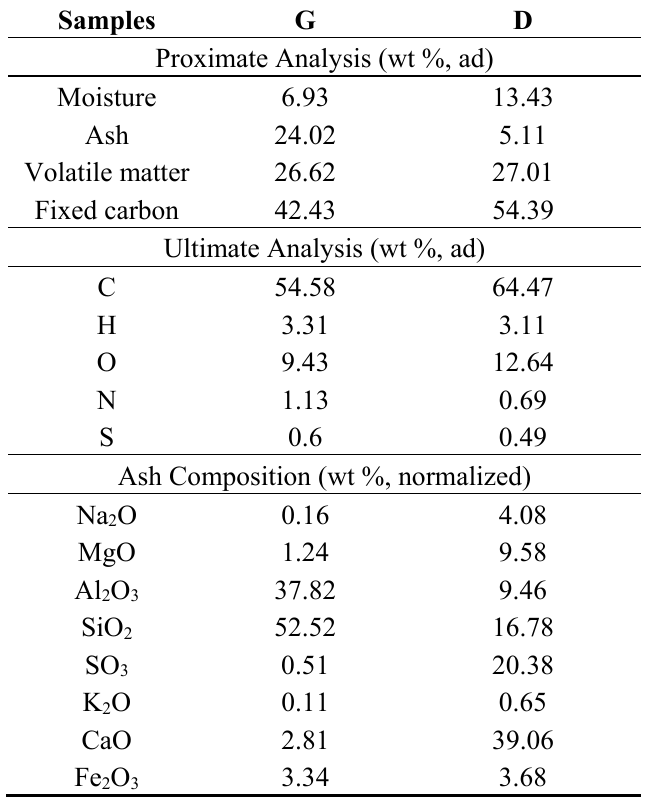
Table 1. Coal analysis (air-dried basis) and ash